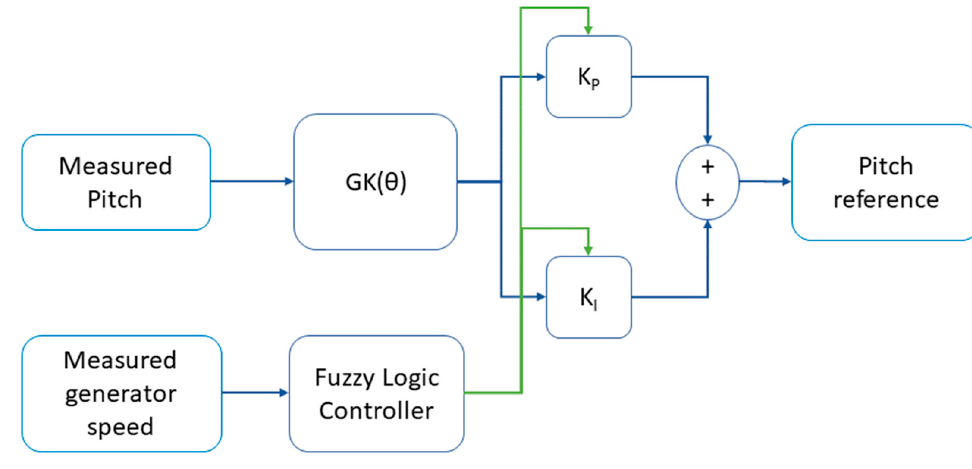
Figure 6. Simplified block diagram of the supervisor fuzzy controller.